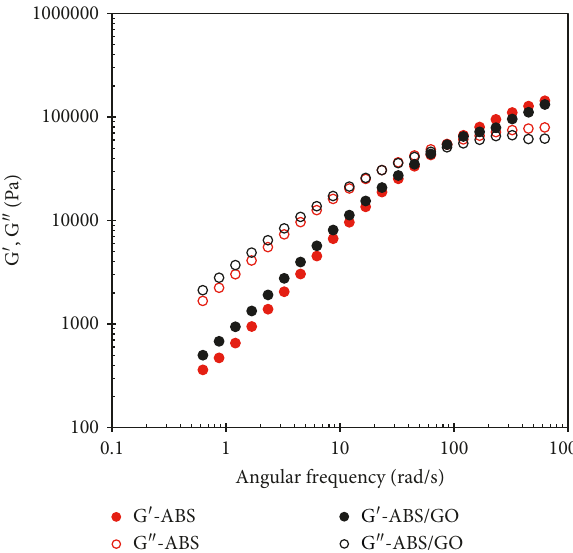
Figure 9: Storage modulus (G angular frequency for ABS filament and ABS/GO composite filament.